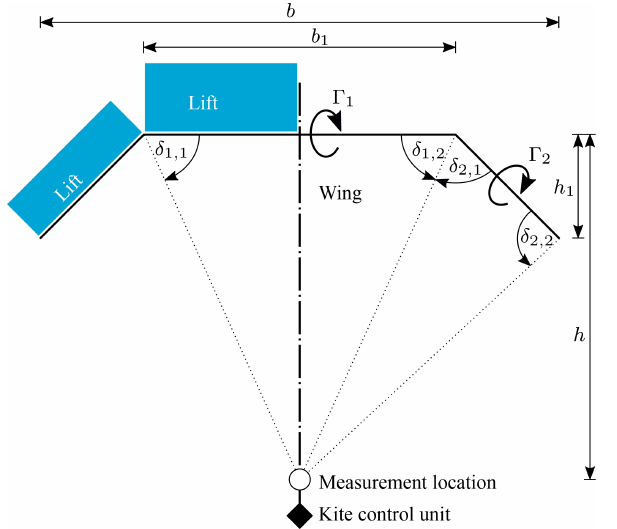
Figure A1. Front view of the lifting-line model of the kite, flying towards the